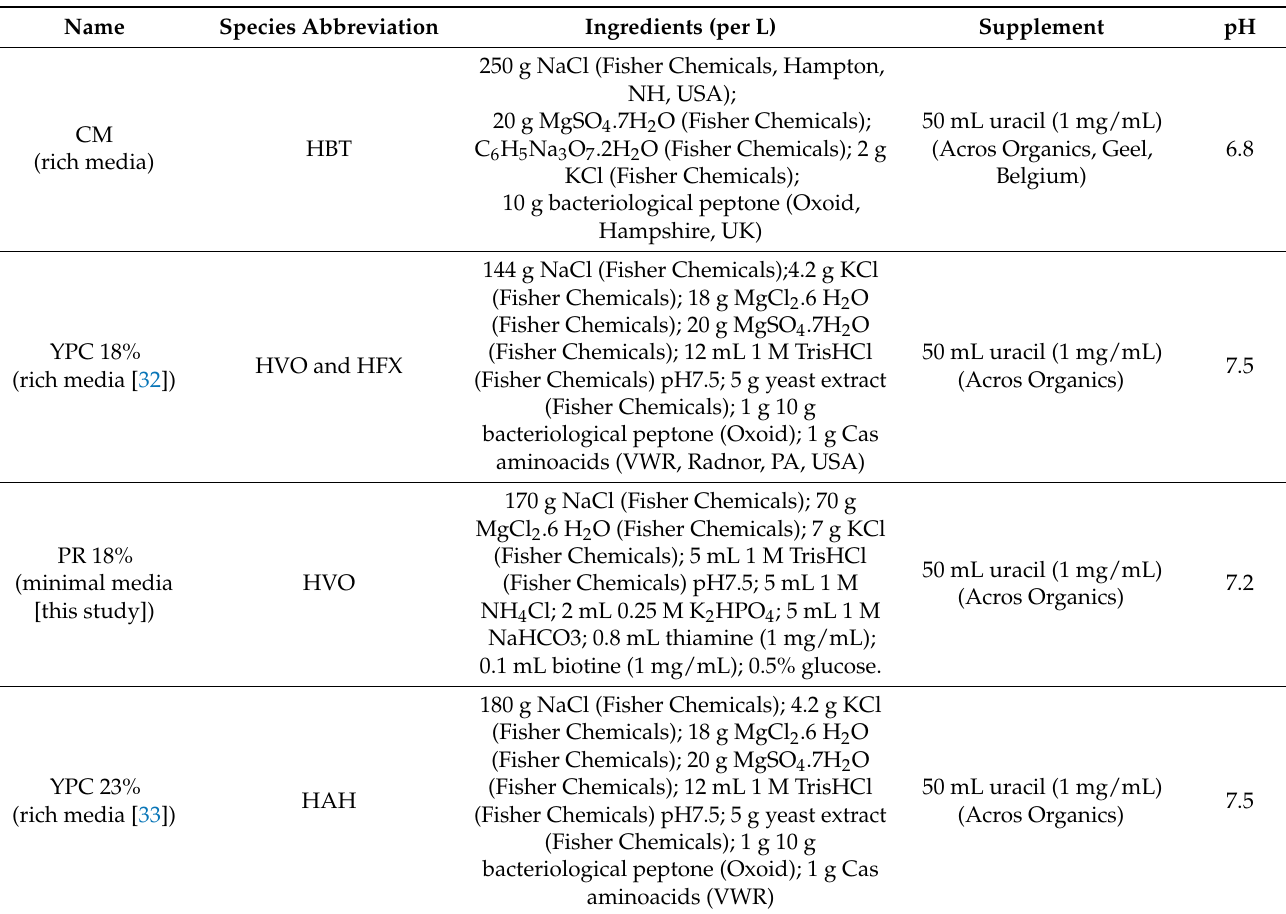
Table 2. All media recipes used for test organisms in this